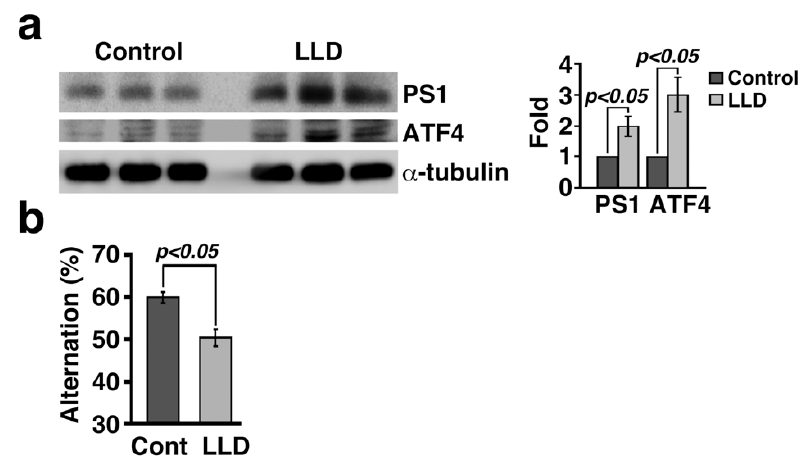
Figure 2. Working memory is impaired in mice fed with amino acid imbalanced food. ( a ) PS1 and ATF4 expression are significantly increased in the brain of mice fed with leucine- and lysine-deficient food (LLD) 30 minutes per week, for ten times. ( b ) Percentage of alternation measured in the Y-maze